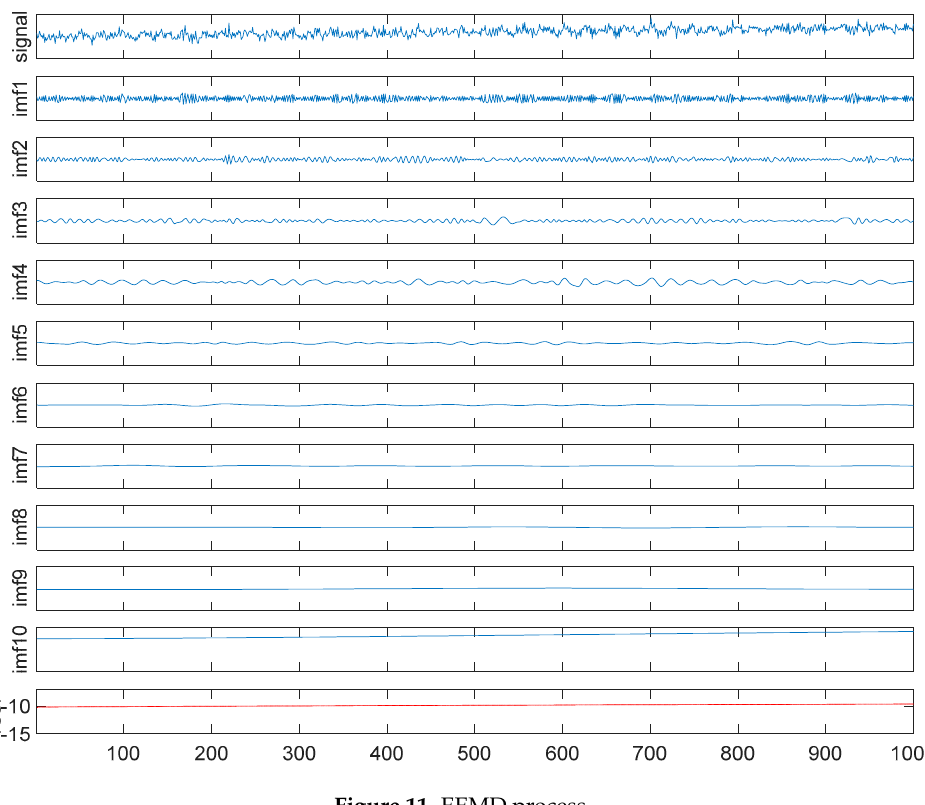
Figure 11. EEMD process.